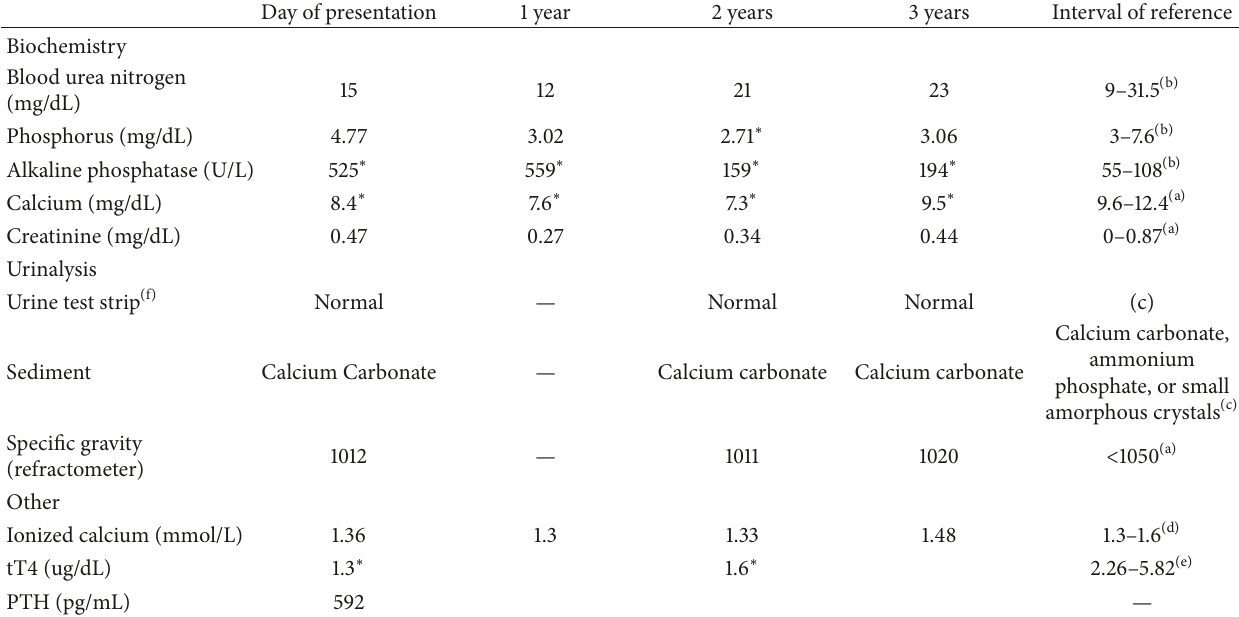
Table 1: Relevant laboratory findings in a satin guinea pig with fibrous